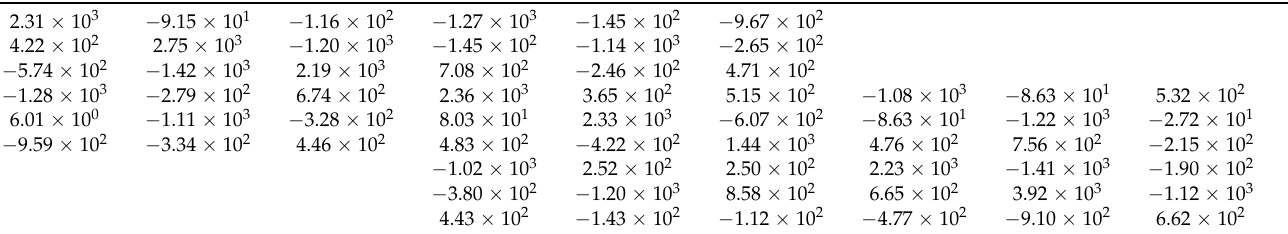
Table 5. The first term K I in the deformed configuration obtained applying F 2 y = 50 ( µ T